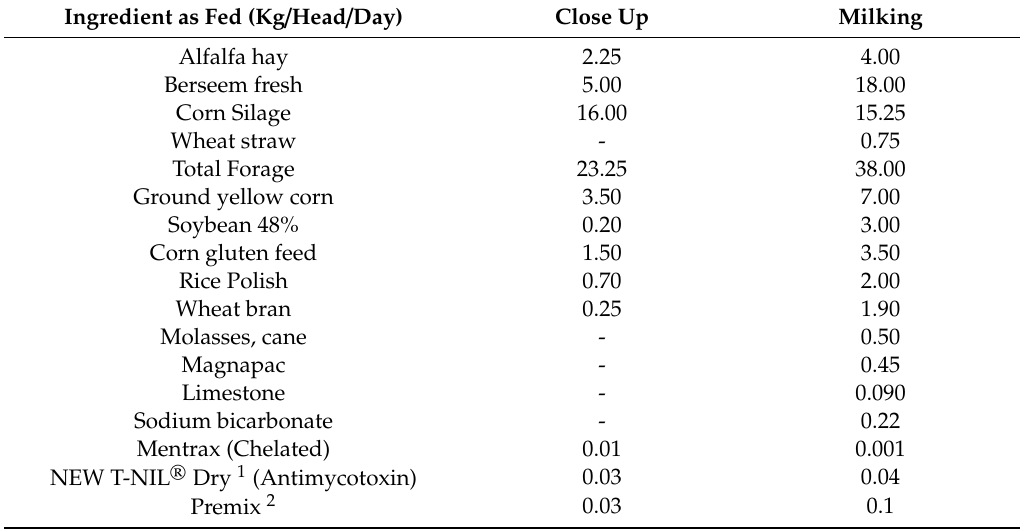
Table 1. Ingredients and chemical analysis of total mixed